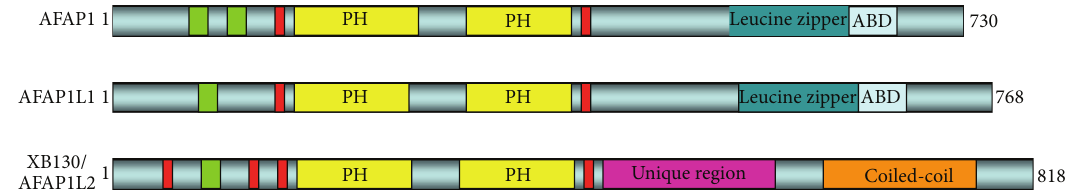
Figure 2: AFAP family proteins. XB130 shares both sequence and structural similarities to the AFAP family of proteins.